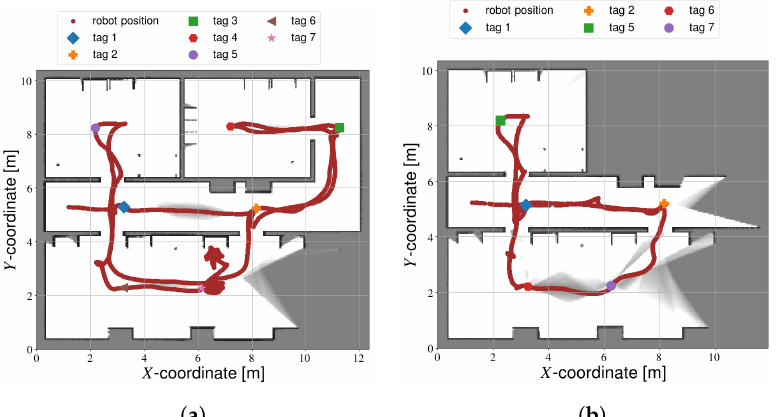
Figure 11. Calibration results from failed fully autonomous simulations. ( a ) Simulation where all but one tag was mapped. ( b ) Simulation that failed to map three tags.